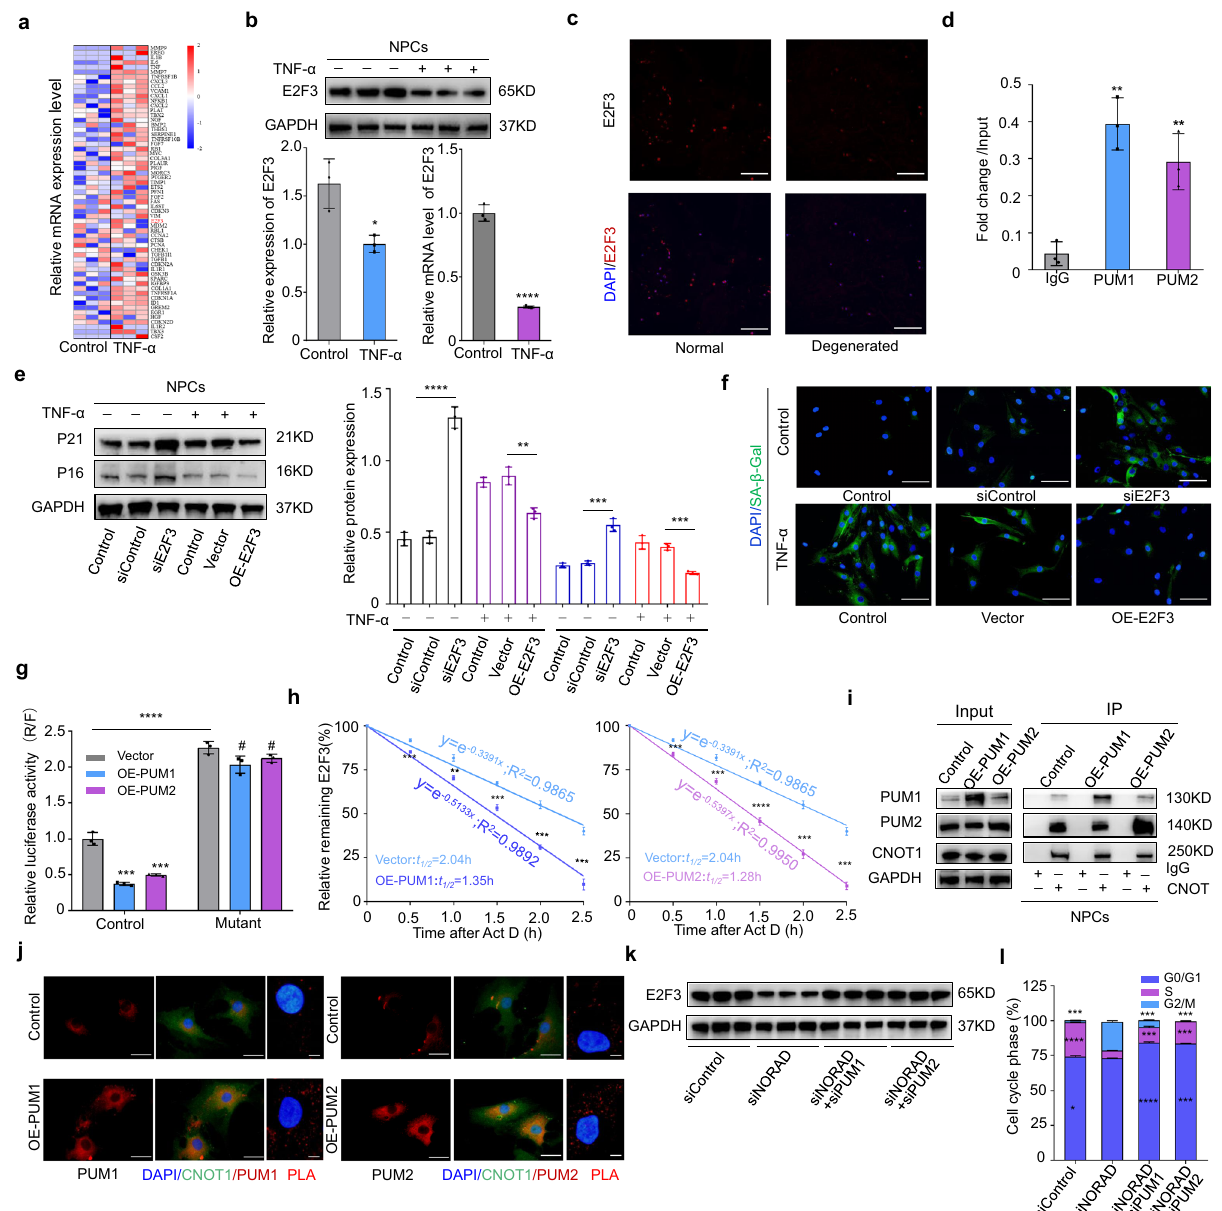
Fig. 8 PUMILIO drives NPC senescence by repressing E2F3. a Heatmap of senescence-associated genes in NPCs by sequencing. b Expression of E2F3 in NPCs by western blot ( P = 0.0167) and RT-qPCR ( P < 0.0001). Data are shown as the mean ± SD, n = 3, * P < 0.05, **** P < 0.0001, two-tailed unpaired Student ’ s t test. c IF of E2F3 in NP tissues (red: E2F3; blue: DAPI; scale bar: 200 μ m). d RIP-qPCR and RNA pulldown assay to determine the binding status of PUM1 ( P = 0.0014) and PUM2 ( P = 0.0064) with E2F3 transcripts. Data are shown as the mean ± SD, n = 3, ** P < 0.01, two-tailed unpaired Student ’ s t test. e Protein level analysis of P21 and P16 in normal ( P < 0.0001; P = 0.0034) and senescent NPCs ( P = 0.0006; P = 0.0002) with or without E2F3 silencing or overexpression, GAPDH was used as the loading control. Data are shown as the mean ± SD, n = 3, ** P < 0.01, *** P < 0.001, **** P < 0.01, two-tailed unpaired Student ’ s t test. f IF analysis of SA- β -gal activity (green: SA- β -gal; blue: DAPI; scale bar: 100 μ m) in NPCs with E2F3 silencing (siE2F3) or overexpression (OE-E2F3). g Dual-luciferase reporter assay of NPCs containing control ( P = 0.0003; P = 0.0006) or mutPRE ( P = 0.0521; P = 0.0703) with or without PUM1/2 overexpression. Data are shown as the mean ± SD, n = 3, # NS, *** P < 0.001, **** P < 0.0001, two-tailed unpaired Student ’ s t test. h Stability of E2F3 transcript in senescent NPCs with PUM1 ( P = 0.0006; P = 0.001; P = 0.0002; P = 0.001; P = 0.001) or PUM2 ( P = 0.0008; P = 0.0008; P < 0.0001; P = 0.0001; P = 0.0001) overexpression. Data are shown as the mean ± SD, n = 3, ** P < 0.01, *** P < 0.001, two-tailed unpaired Student ’ s t test. i Co-IP analysis of CNOT1 interaction with PUM1 or PUM2 in NPCs with or without PUM1/2 overexpression. j IF analysis of the interaction of CNOT1 with PUM1 or PUM2 in NPCs with or without PUM1/2 overexpression (red: PUM1/2; green: CNOT1; blue: DAPI; scale bar: 50 μ m); Interaction of CNOT1 with PUM1 or PUM2 by PLA (red: Signal; blue: DAPI; scale bar:10 μ m). k Expression of E2F3 in NORAD-silenced NPCs with or without PUM1/2 silencing. l Cell cycle analysis of NORAD-silenced NPCs with or without PUM1/2 silencing at G0/G1 ( P = 0.0125; P < 0.0001; P < 0.0001), S ( P < 0.0001; P < 0.0001; P < 0.0001), G2/M phase ( P < 0.0001; P < 0.0001; P < 0.0001). Data are shown as the mean ± SD, n = 3, * P < 0.05, ** P < 0.01, two-tailed unpaired Student ’ s t